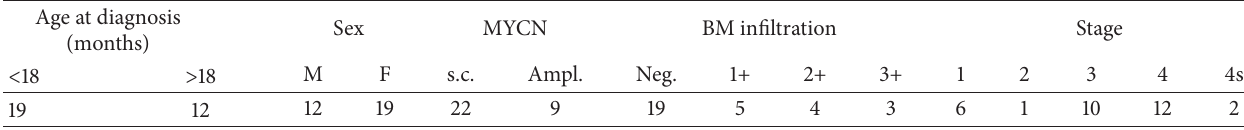
Table 1: Neuroblastoma patients’ characteristics. First row indicates all the variables analyzed in NB patients, second row indicates the subgroups for each variable, and third row indicates the number of subjects in each group.